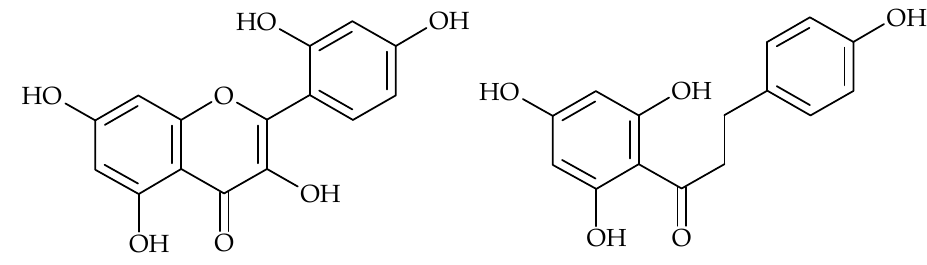
Figure 7. Chemical structures of morin ( left ) and phloretin ( right ).